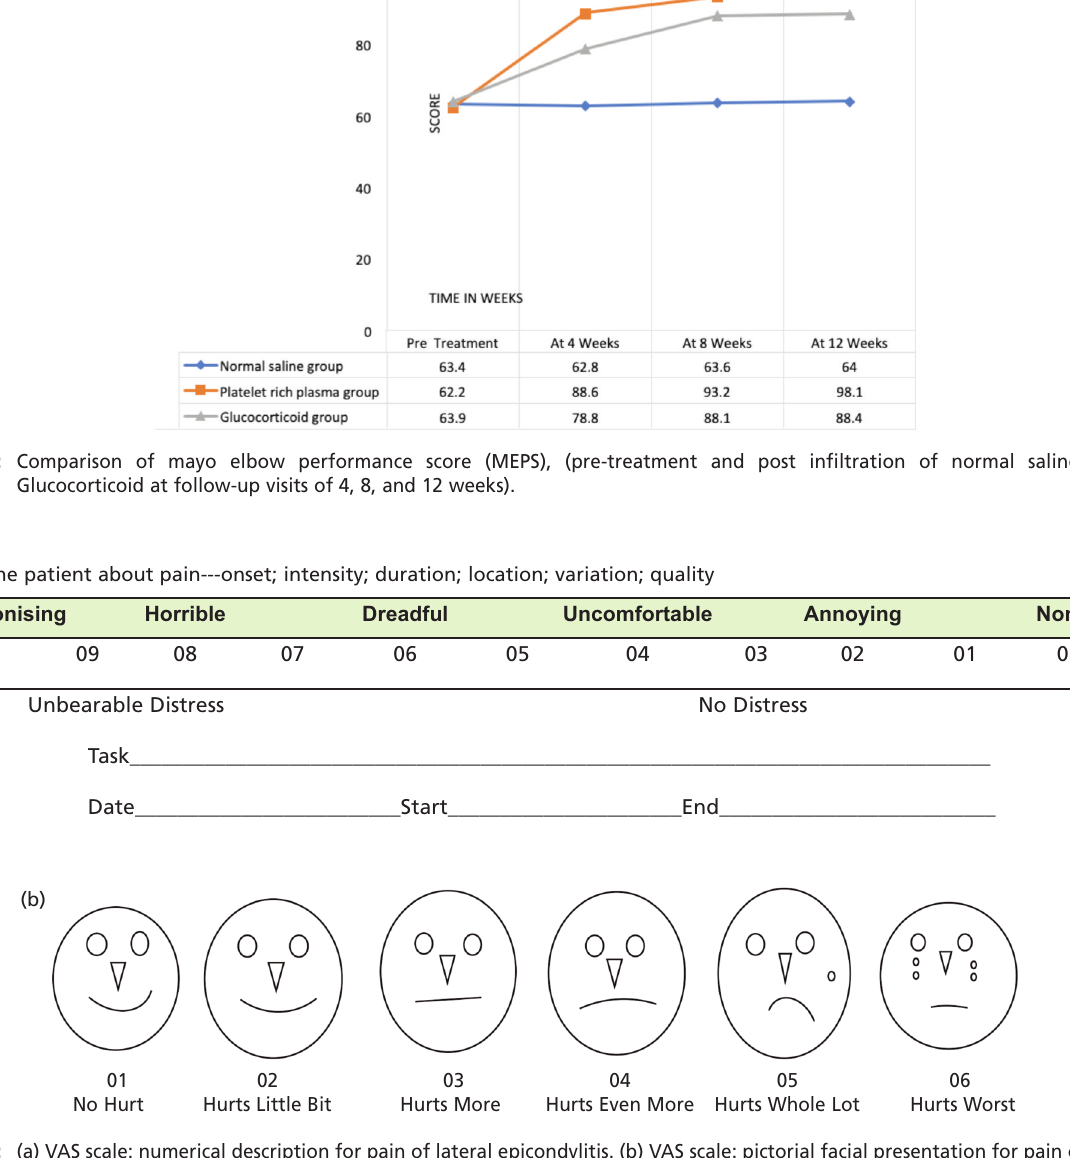
(a) VAS scale: numerical description for pain of lateral epicondylitis. (b) VAS scale: pictorial facial presentation for pain of lateral Fig. 2: